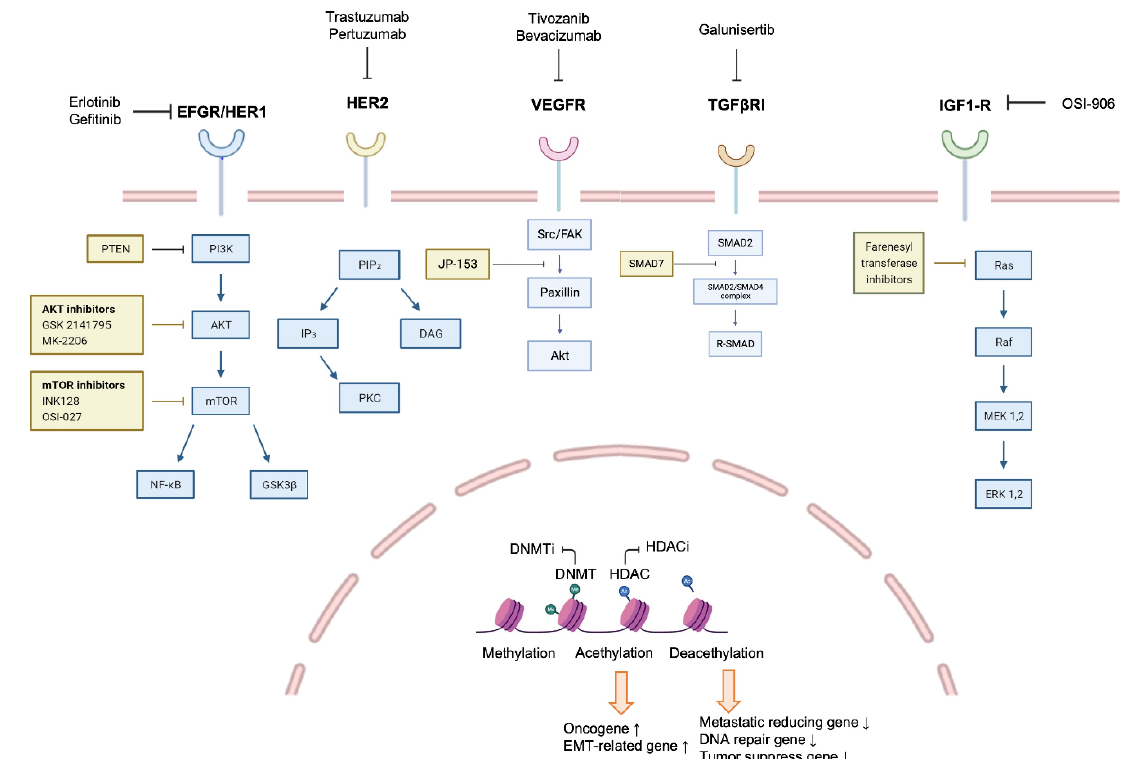
Breast cancer is a heterogeneous disease where the treatments are not limited to one (Figure 1). Targeted therapies such as trastuzumab and pertuzumab are generally used in combination with other anticancer drugs. In the HER2-positive subtype, various therapeutics targeting HER2 have been developed. In fact, trastuzumab or docetaxel plus pertuzumab was effective in metastatic breast cancer [117]. In addition, significant results were obtained when tucatinib was used in combination with trastuzumab and capecitabine for patients with HER2-positive metastatic breast cancer [118]. In particular, TNBC with BRCA1 mutation responds to PARP inhibitors [119]. However, the possibility of the recurrence and metastasis of all types of breast cancer still exists.